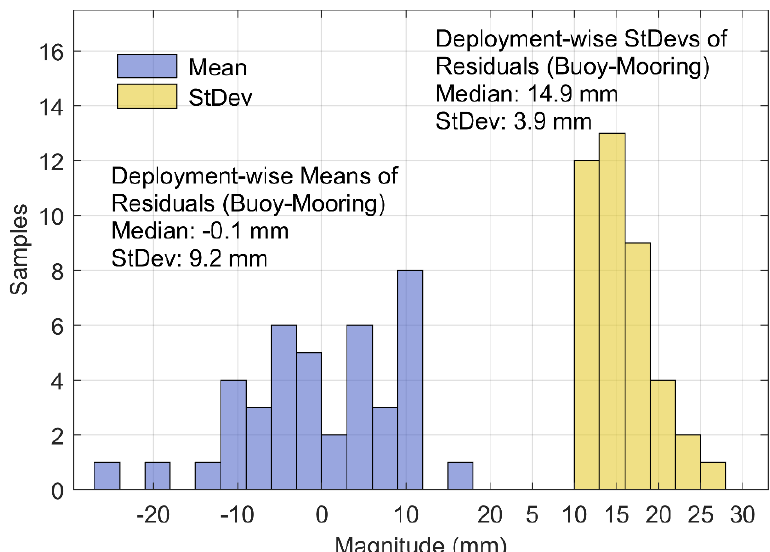
Figure 2. Distribution of summary statistics derived from buoy against mooring residuals. StDev stands for standard deviation. Blue histogram shows the distribution of deployment-wise means of residuals; Yellow histogram shows the distribution of deployment-wise standard deviations. A total number of 27 deployments, 2015 h of data is used in the histogram.